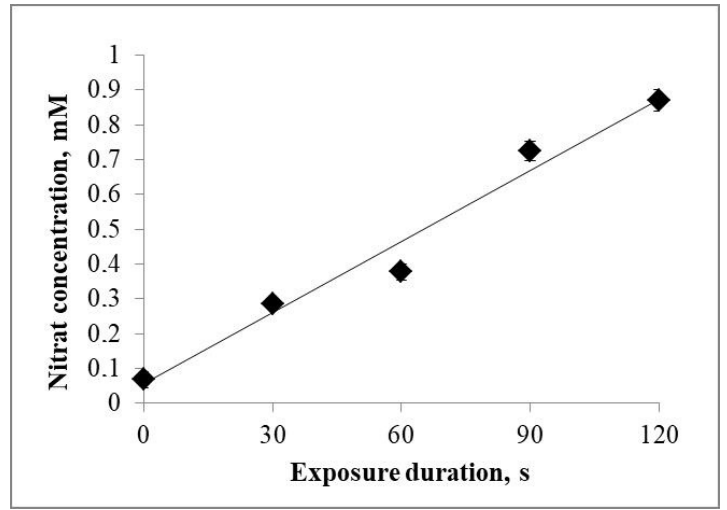
Figure 4. Dependence of oxygen peroxide concentration in the physiological solution on the pro- cessing time by direct piezodischarge. The distance between the piezotransformer and the solution surface was 0.5 mm. The temperature of the surrounding medium was 20 ± 2 °C, and the air hu- midity was 70 ± 3%. In detail, the experimental conditions are described in the Section 2